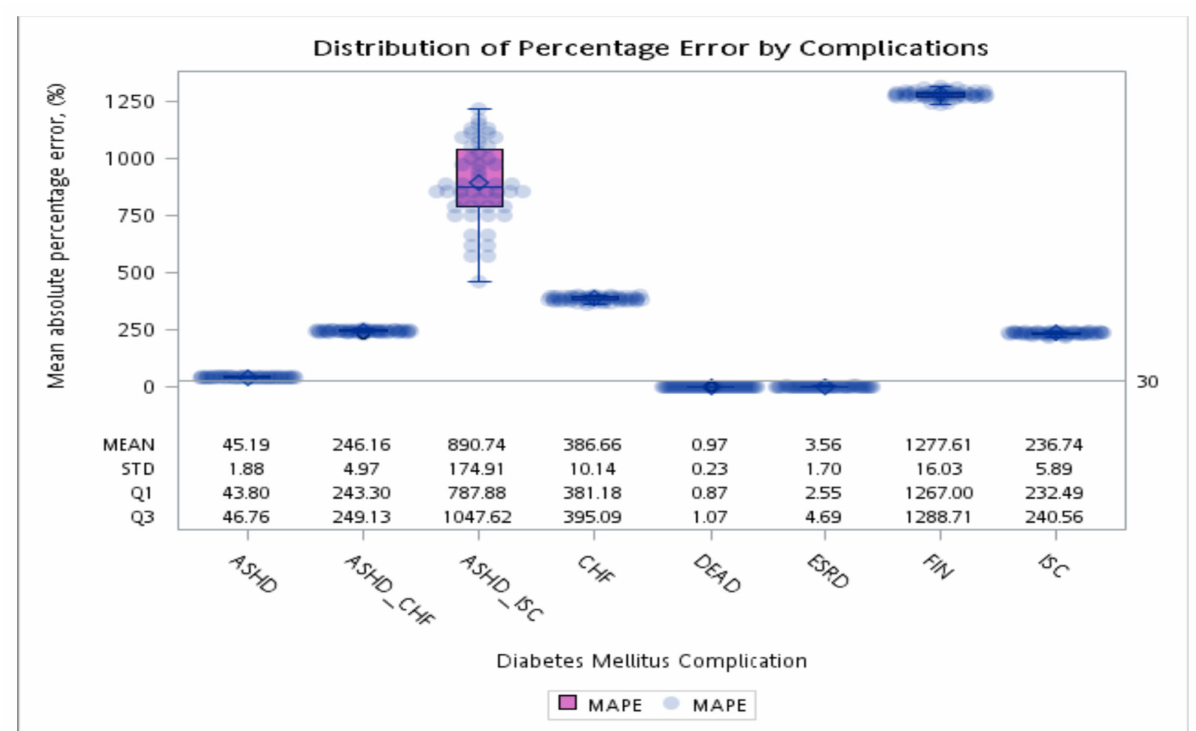
Figure 9. Average absolute percentage error of the first event (complication or death) after diabetes diagnosis between the simulation and observations in 10 years.